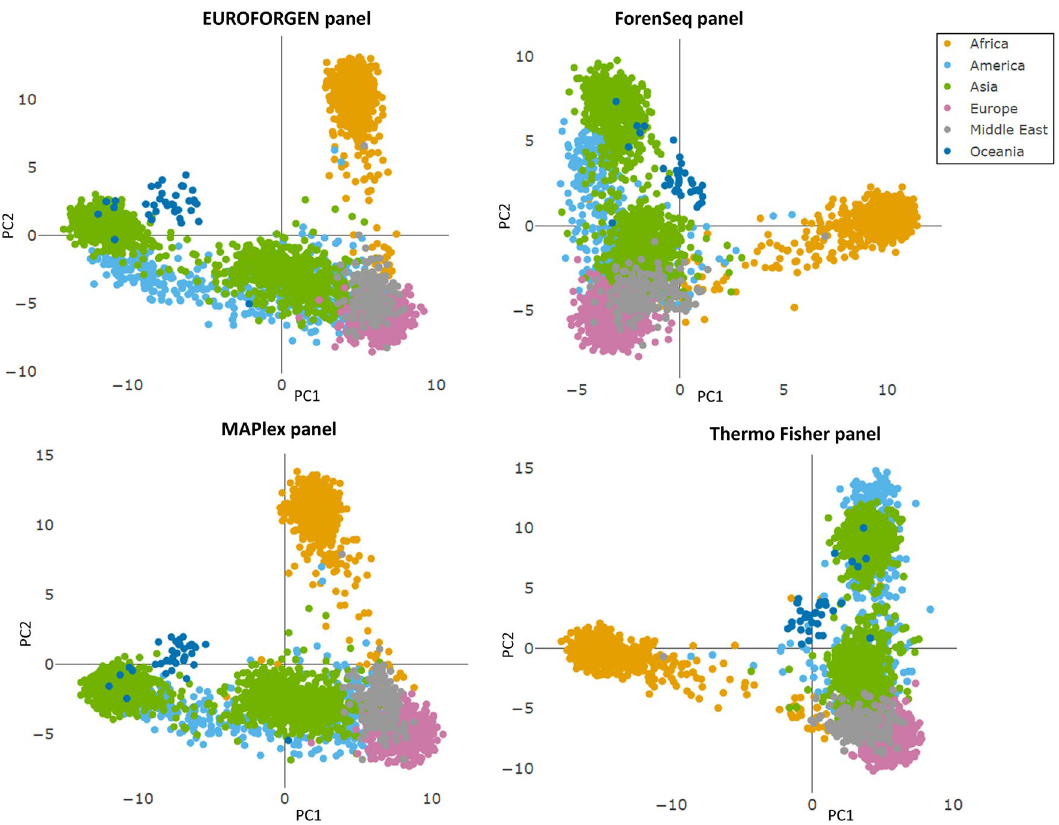
Figure 1. PCA Scores plots showing the PCA models obtained for the different evaluated AIMs